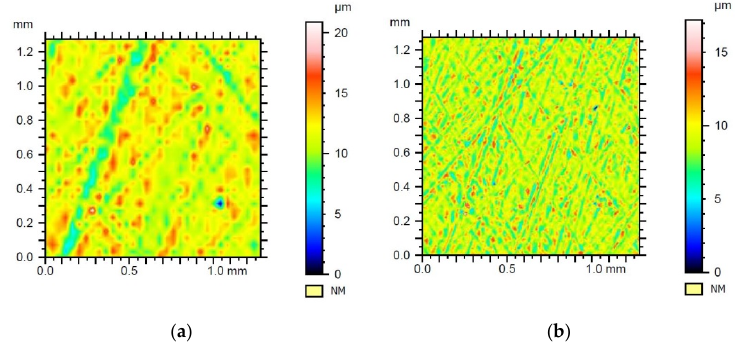
Figure 9. Results of filtration of the surface geometrical structure of sample no. 1 with Daubechies wavelet of the 3rd row with the 3rd level of filtration—( a ) waviness, ( b ) roughness.